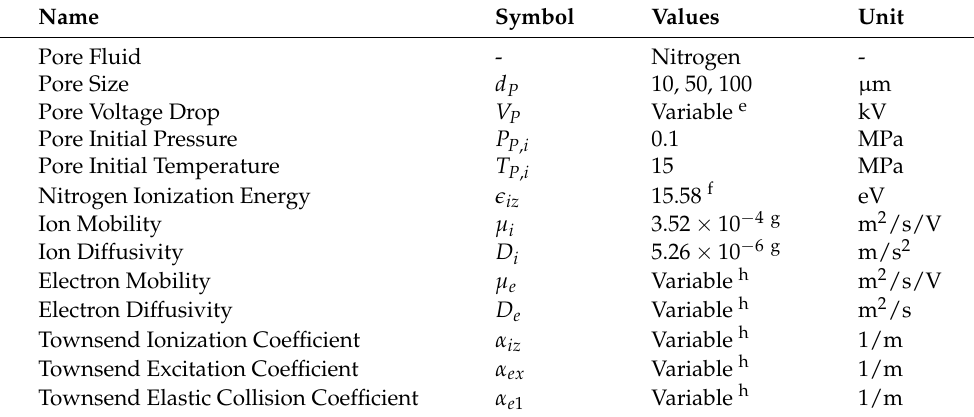
Table 3. ZAPDOS input parameters for our plasma formation